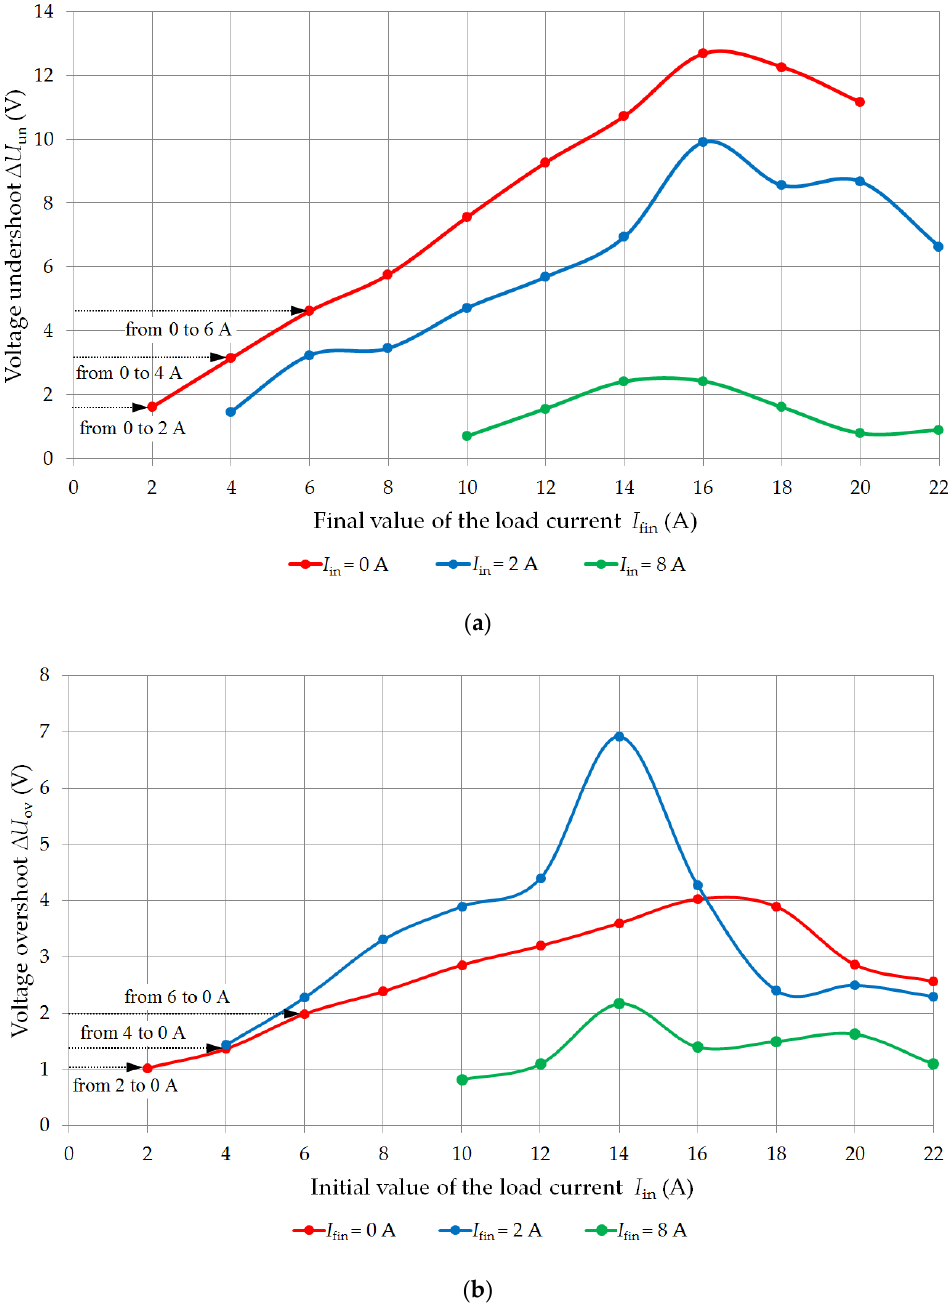
Figure 15. Dependencies of PEMFC characteristics under dynamic load decrease: ( a ) Δ U un on I fin ; ( b ) Δ U ov on I in .